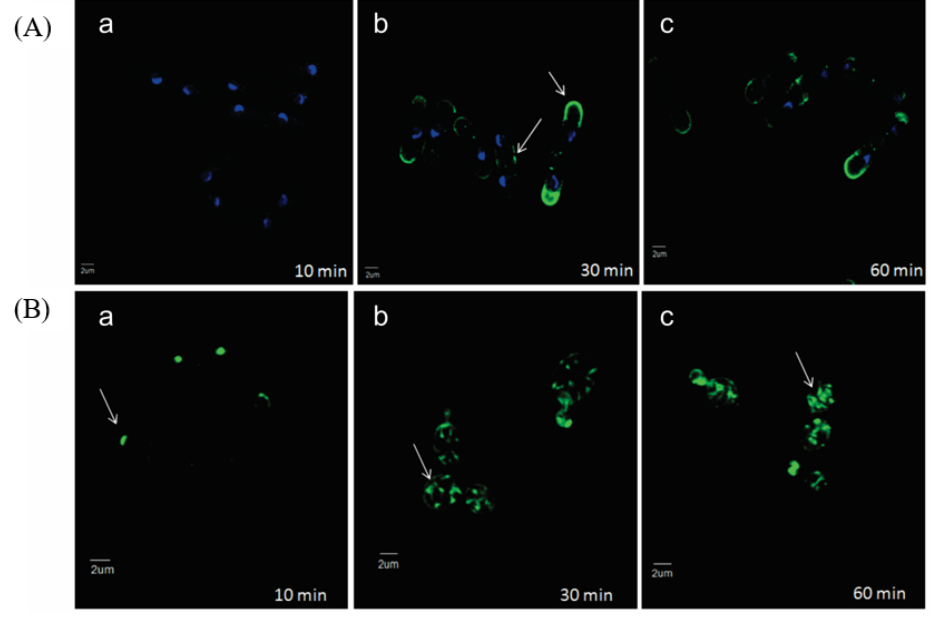
Figure 3. Localization of occidiofungin in yeast cells. ( A ) Alkyne derivatized occidiofungin is localized at the cell tips and division septa of dividing Schizosaccharomyces pombe cells by (b) 30 min and (60) min. ( B ) A time-course distribution of alkyne derivatized occidiofungin within Saccharomyces cerevisiae from 10 (a), 30 (b), and 60 (c) min. At 10 min, occidiofungin is localized at the bud tips of dividing S. cerevisiae cells. By 30 min, vesicular patterns are observed, which indicated endocytic vesicles coated by actin bound with occidiofungin. Localization of occidiofungin is demarcated with white arrows. Blue fluorescence is DAPI stain showing chromosome positions, and the green fluorescence is the azide-derivatized Alexa Fluor 488 stain bound to alkyne occidiofungin. Adapted from Ravichandran et al [9].